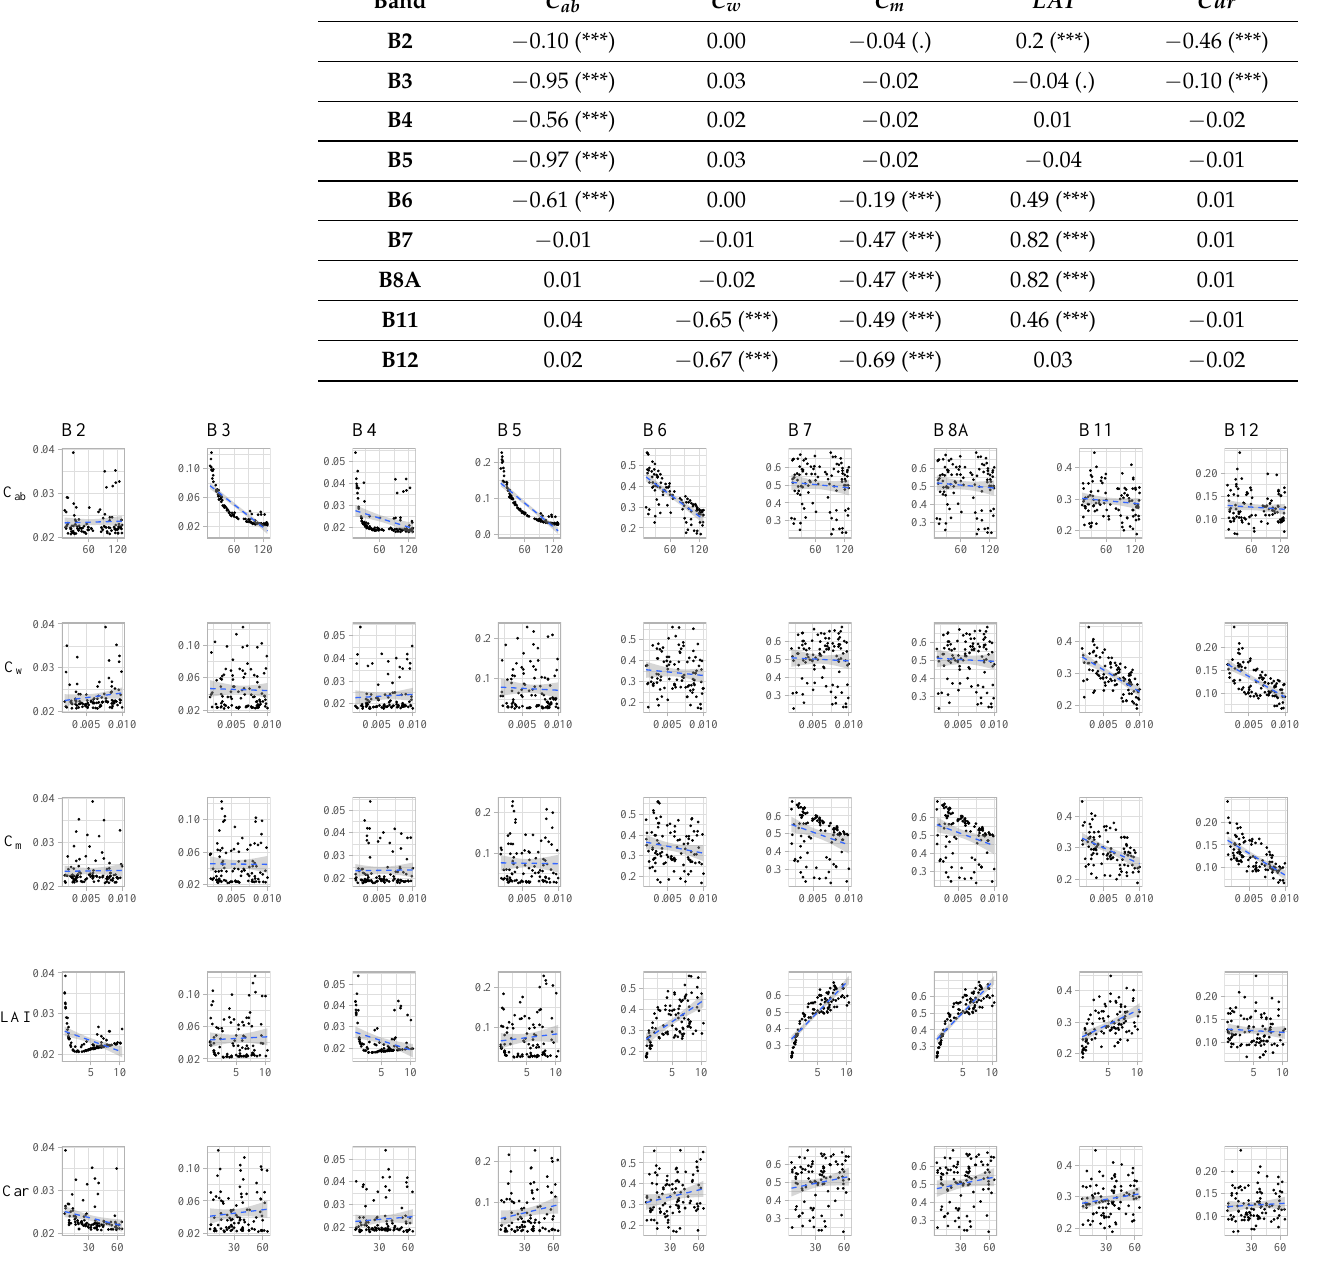
Figure 3. Scatterplot between each trait and band. To improve visualization, only a fraction of 100 samples were used in this